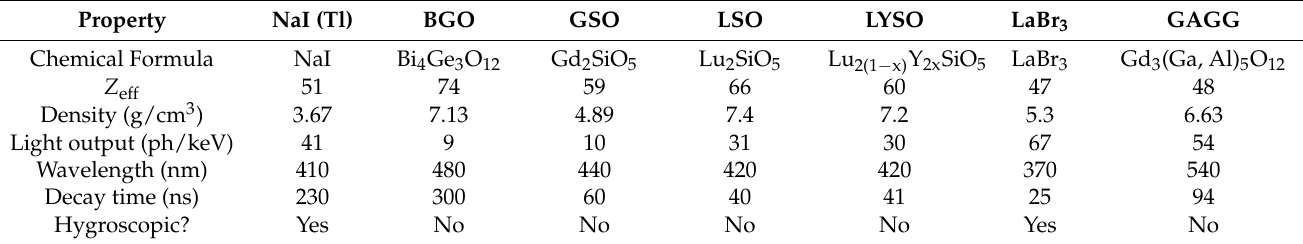
Table 1. Basic properties of common scintillation crystals used in PET